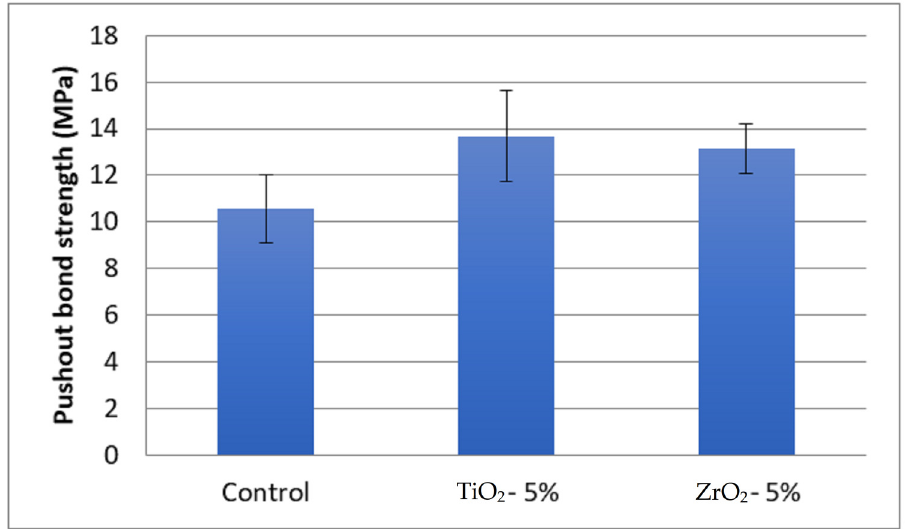
Figure 6. Comparison of means and standard deviations of push-out bond strength (MPa) among study groups.